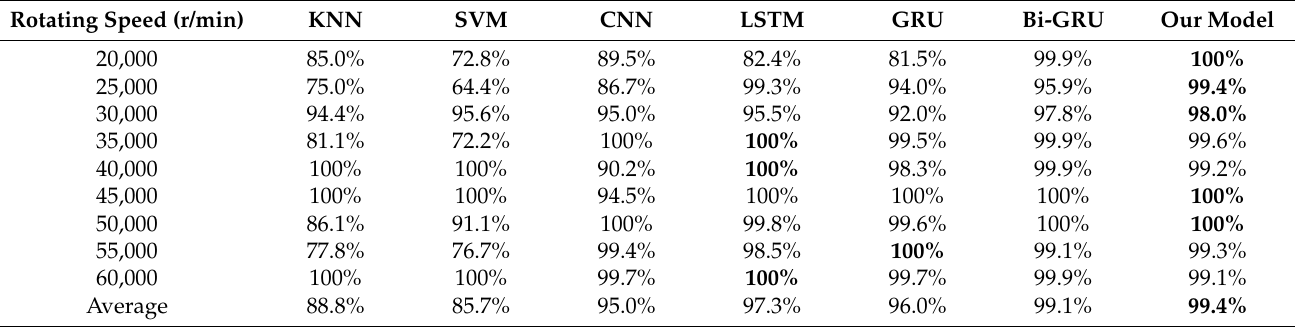
Table 3. The testing accuracy of the fault